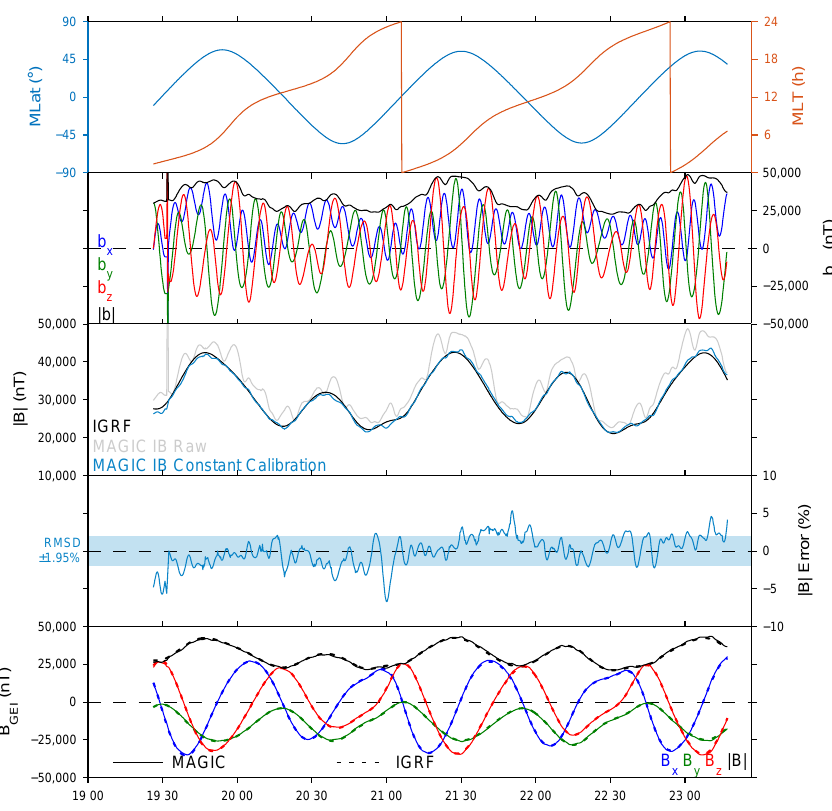
Figure 2. Attitude mode data from the inboard MAGIC sensors. From top to bottom: magnetic latitude (blue) and magnetic local time (orange) of CINEMA; raw data from the three sensors (x, y, z in blue, green, red) with field strength shown in black; comparison of the raw (grey) and calibrated (blue) data to IGRF (black); percentage error of the calibrated field strength to IGRF, where the shaded area indicates the root mean squared error; comparison of despun calibrated data (solid) with IGRF (dotted) in GEI